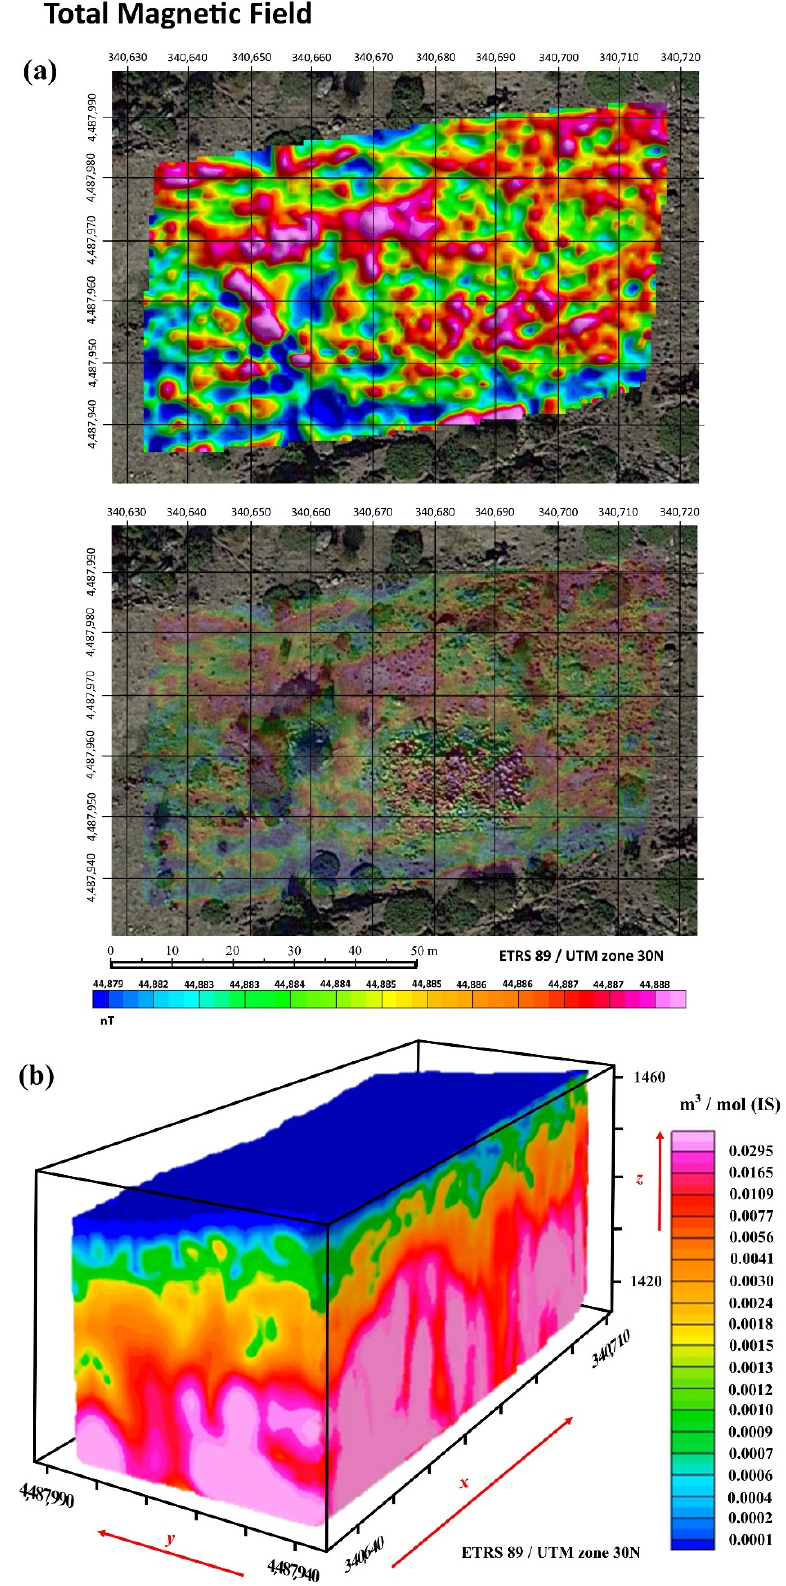
Figure 7. Total magnetic field. ( a ) Surface magnetometric map with representation of the total magnetic field at depth (nT). ( b ) Magnetometric 3D map with representation of the magnetic susceptibility at depth (magnetic susceptibility), logarithmic scale.